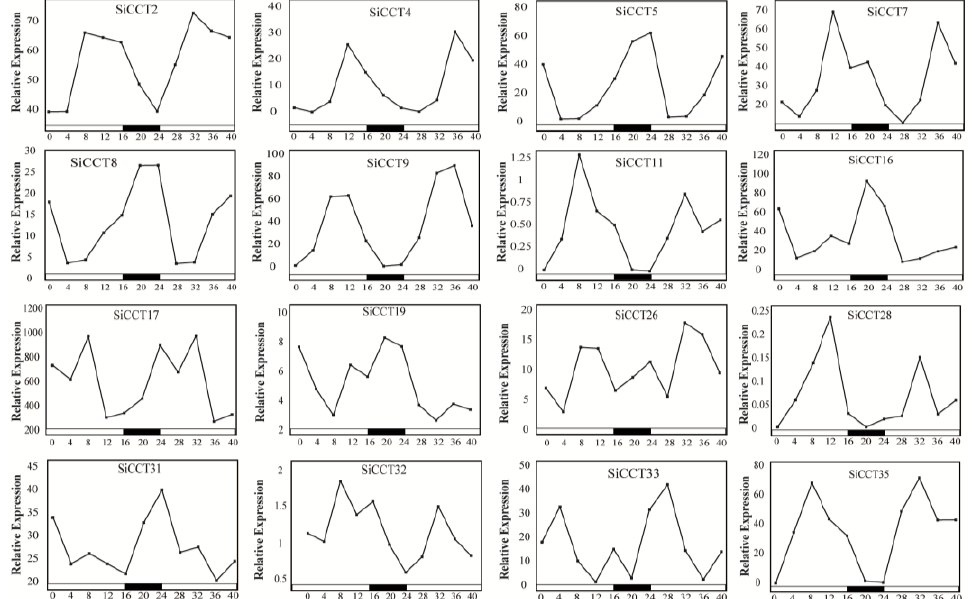
Figure 7. Expression pattern of SiCCT proteins under long days. White and black bars represent light and dark periods, respectively. The gene expression level was the FPKM value calculated.